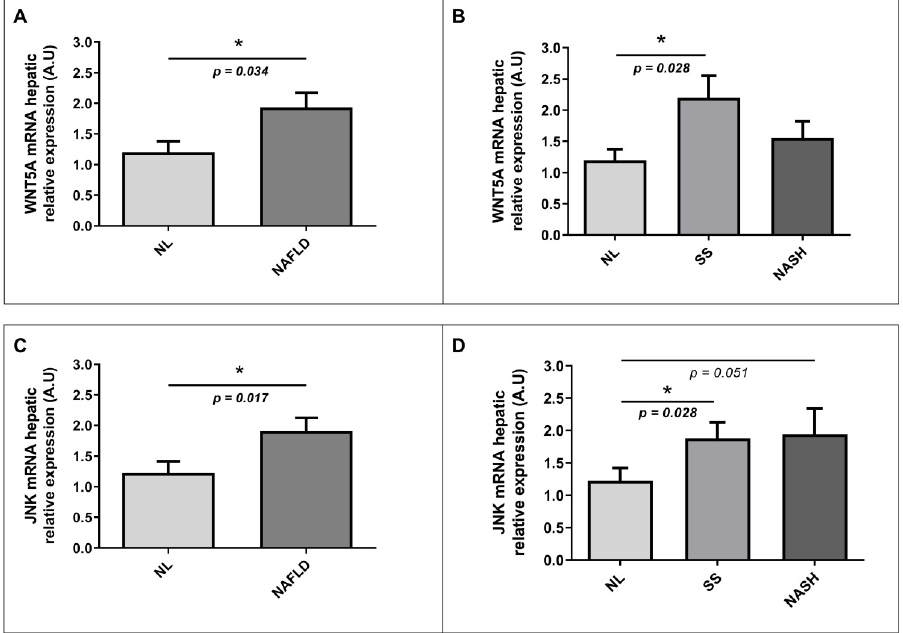
Figure 5. Differential relative mRNA abundance of WNT5A in liver between ( A ) women with MO and NL histology and women with MO with NAFLD; ( B ) women with MO with NL histology, women with MO with SS, and women with MO with NASH. Differential relative mRNA abundance of JNK in liver between ( C ) women with MO with NL histology and women with MO with NAFLD; ( D ) women with MO with NL histology, women with MO with SS, and women with MO with NASH. A.U, arbitrary units; MO, morbidly obesity; NAFLD, nonalcoholic fatty liver disease; NL, normal liver; SS, simple steatosis; NASH, nonalcoholic steatohepatitis; WNT5A, WNT family member 5a; JNK, Jun N-terminal kinase. p < 0.05 was considered statistically significant (* means p < 0.05).